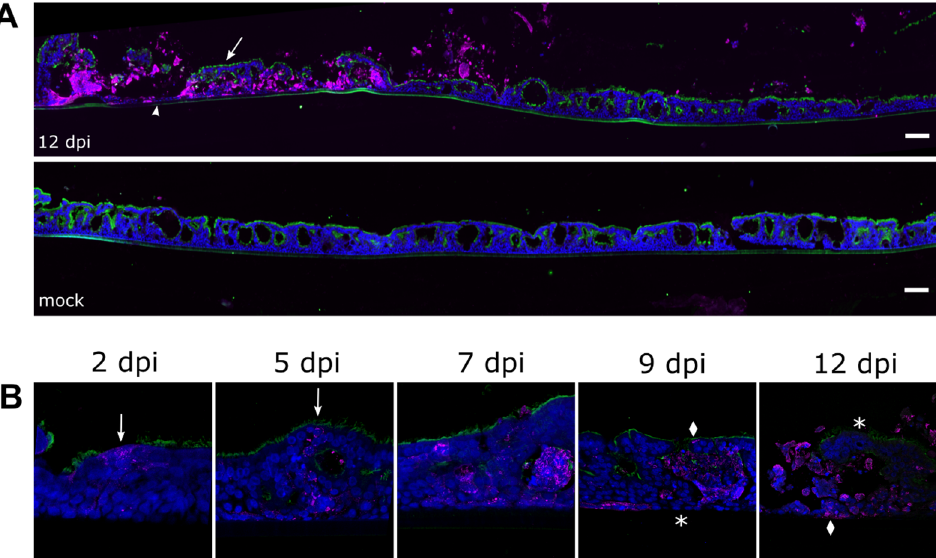
Figure 3. Time course of NiV infection and cytopathic effects. Immunostaining of NiV-infected PBEC-ALI culture cross sections against NiV N (magenta) and β -tubulin (green). ( A ) A large membrane section from 12 dpi at the top and the mock control at the bottom. Arrow and arrowhead indicate less infected and destructed areas of ciliated and basal cells, respectively. Scale bars = 100 µm. ( B ) Time course of NiV infection for 12 dpi with representative sections. Arrows indicate an infection in ciliated and non-ciliated cells of the apical cell layer. Diamonds mark infected cells and stars non-infected cells. Nuclei were stained with Hoechst 33342.